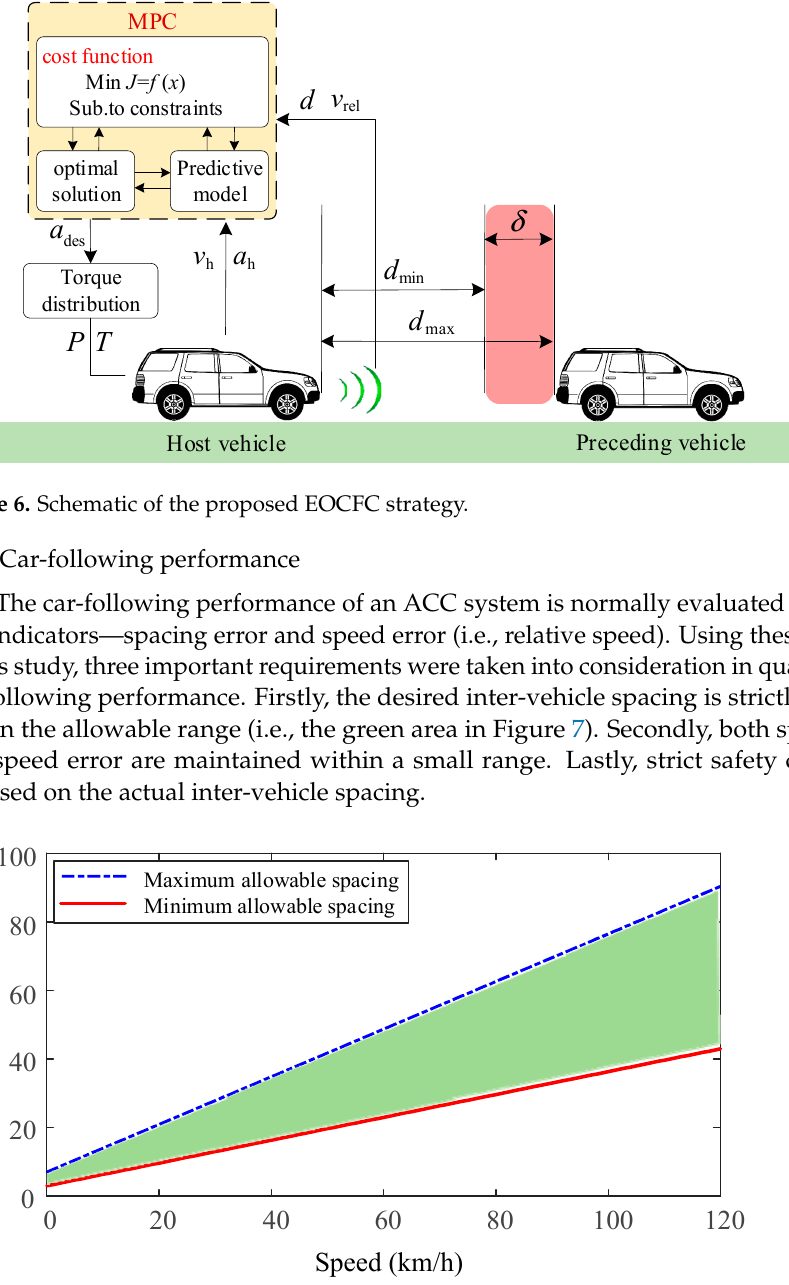
1 Figure 5. Battery efficiency map. 3. Economy-Oriented Car-Following Control Strategy In the car-following mode, the host vehicle follows the preceding vehicle and main- tains a safe inter-vehicle spacing. It is a challenging task to optimize the economy perfor- mance in this mode. On the one hand, the reduction in energy consumption can result in deterioration of car-following performance (i.e., increased spacing error). On the other hand, if the host vehicle strictly follows a desired inter-vehicle spacing, then its energy consumption is deterministic, and economy optimization becomes impossible. Hence, an appropriate trade-off between economy performance and car-following performance